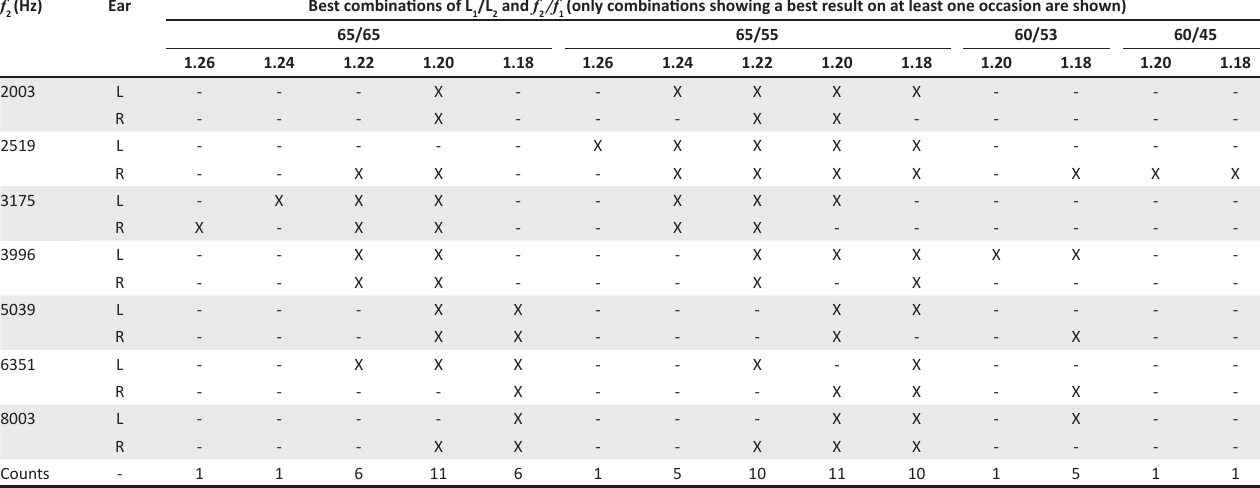
TABLE 2: Results of the mixed model analyses of all level and frequency settings combined. (Hz) f 2